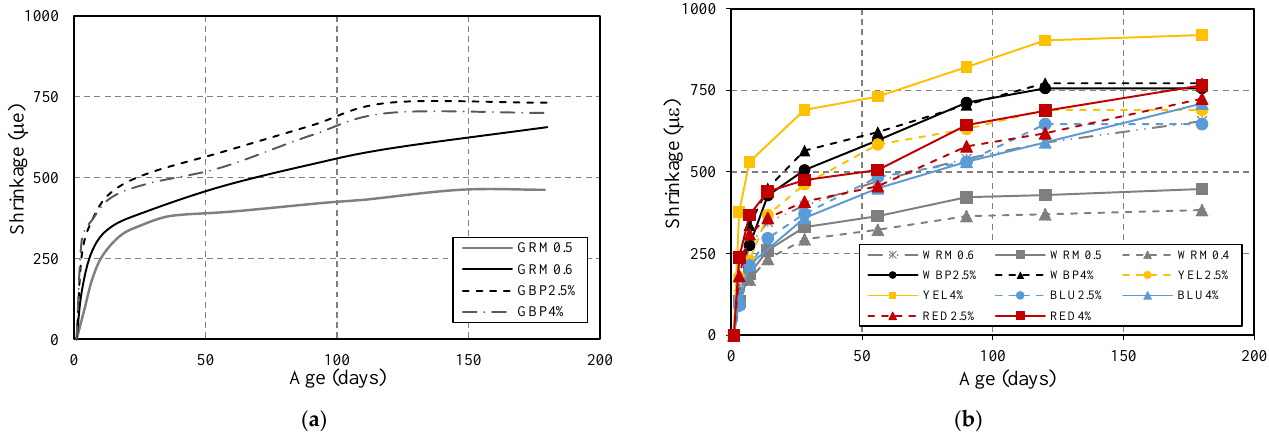
Figure 7. Shrinkage evolution of the produced mortar, with: ( a ) GRM0.5, GRM0.6, GBP2.5%, GBP4%; ( b ) WRM0.6, WRM0.5, WRM0.4, WBP2.5%, WBP4%, YEL2.5%, YEL4%, BLU2.5%, BLU4%, RED2.5%, RED4%.